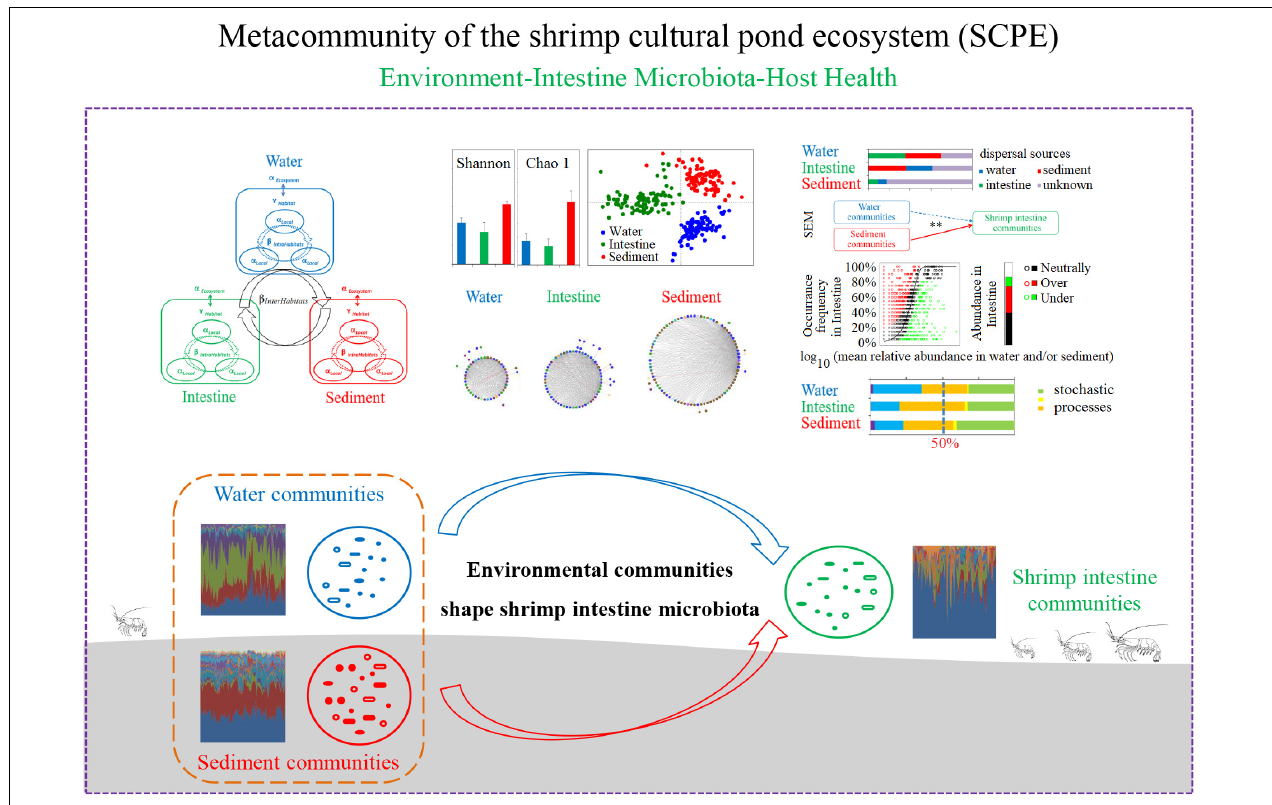
FIGURE 6 | A schematic presentation of microbial assembly mechanisms and relationships among microbial communities of water, shrimp intestine, and sediment habitats in the SCPE